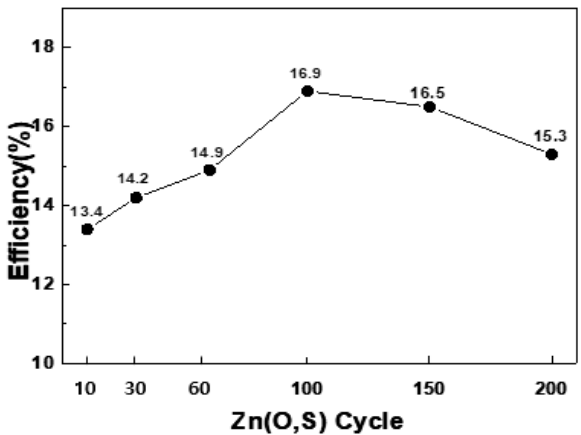
Figure 4. Efficiency of CIGSSe solar cells depending on the Zn(O,S) thickness. Other process conditions: ZnO:ZnS Ratio 4:1, Glass Temperature 120 °C.